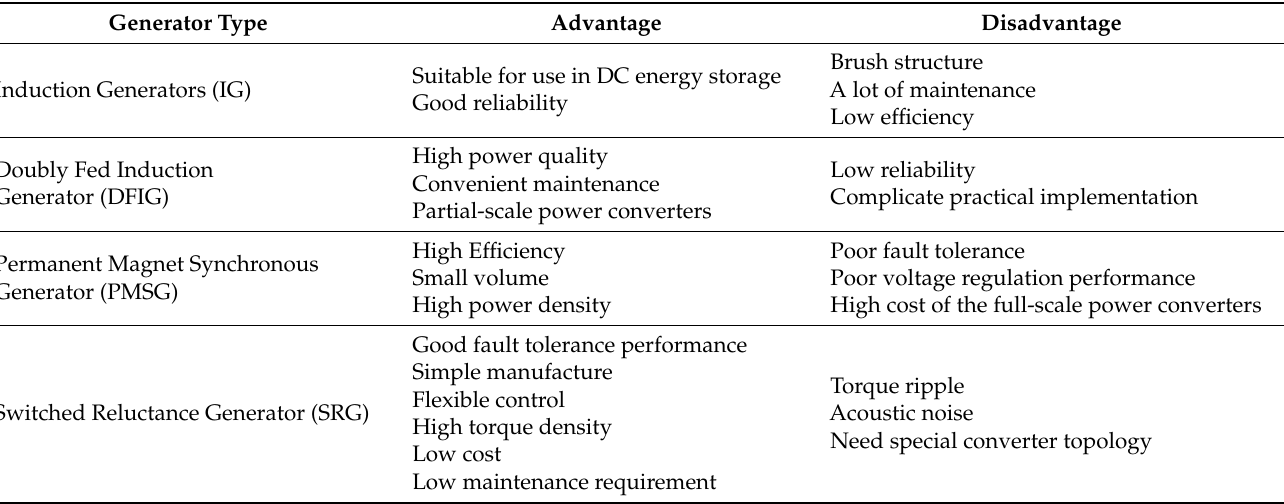
Table 1. Comparison of generators in WECS.